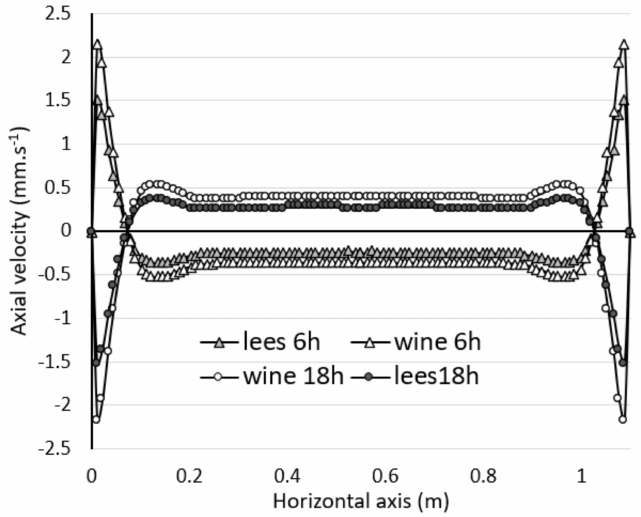
Figure 10. Comparison of the axial velocities of wine and lees, at t = 6 h and t = 18 h, as plotted along a horizontal axis, at y = 110